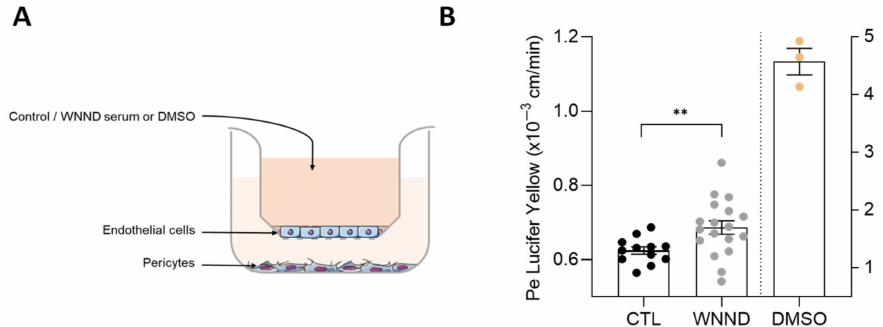
Figure 6. WNND serum slightly perturbs the endothelium in a human BBB model. ( A ) Primary brain pericytes cultured in the basolateral compartment allow differentiation of CD34+ blood cord-derived endothelial cells in human brain-like endothelial cells cultured on transwell filters in the apical compartment. Serum can be added in the apical compartment of this human in vitro BBB model representing the blood. ( B ) Permeability coefficient (Pe) of the paracellular marker Lucifer Yellow was measured 4 days after the addition of CTL or WNND serum or DMSO as a positive control. ** p <